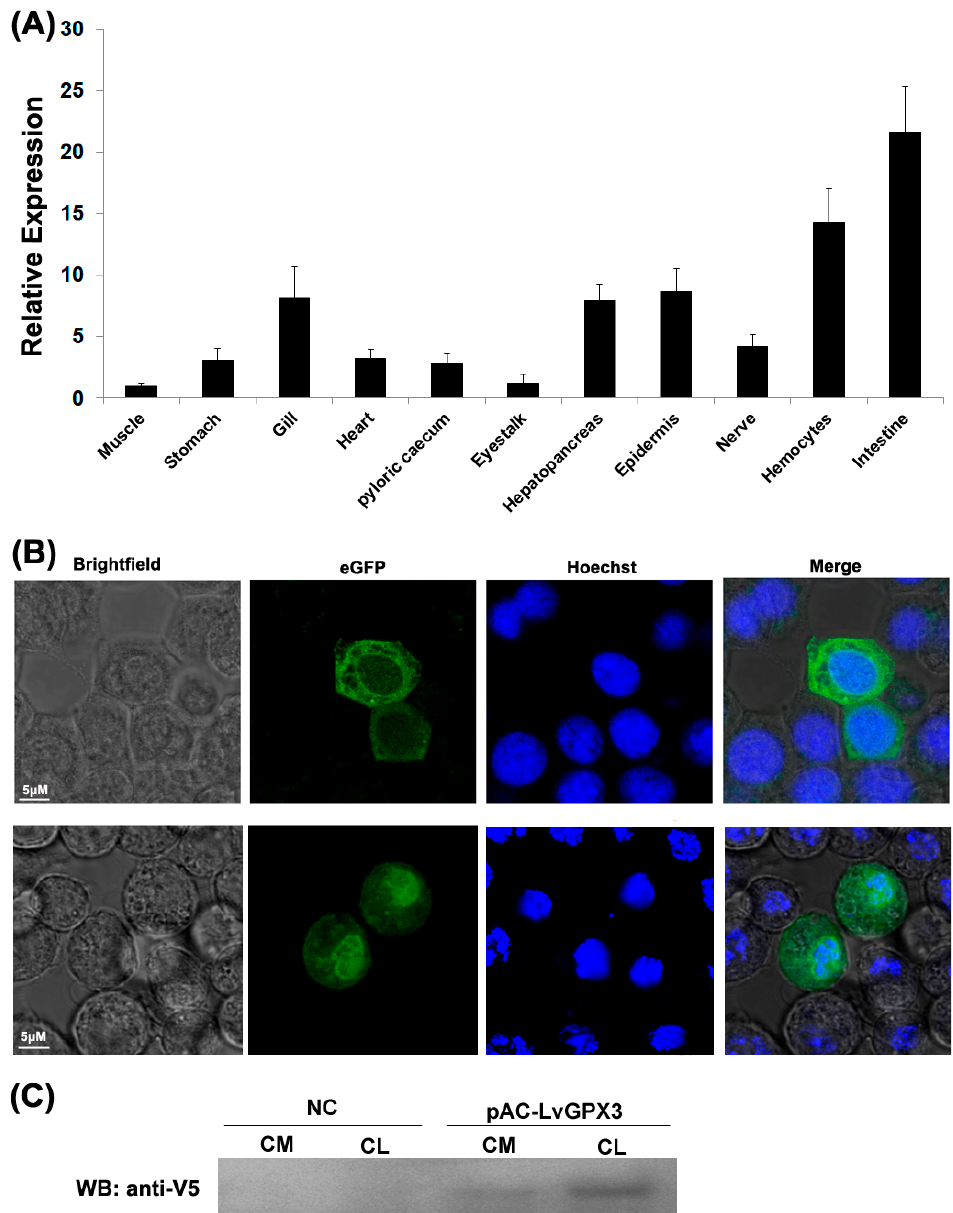
Figure 2. Expression profile of LvGPX3 and secretory expression of LvGPX3. ( A ) Total RNA extracted from different tissues were reversely transcribed into cDNAs to serve as templates. Relative expression levels of LvGPX3 were normalized to LvEF1 α . The results are based on three independent experiments and expressed as mean values ±S.D. ( B ) The location of the proteins was visualized with a Leica laser scanning confocal microscope. ( C ) S2 cells were transfected with pAC-LvGPX3 expression plasmids. At 48 h post transfection, the cells were harvested and the V5-LvGPX3 was detected by Western blot assay using anti-V5 antibody. CM, (Culture media); CL, (Cell lysates).